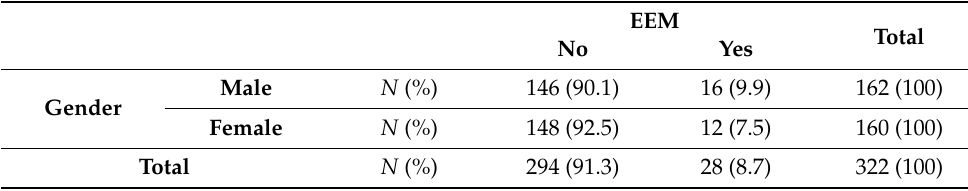
Table 2. Ectopic eruption of the maxillary first permanent molar. Gender distribution.